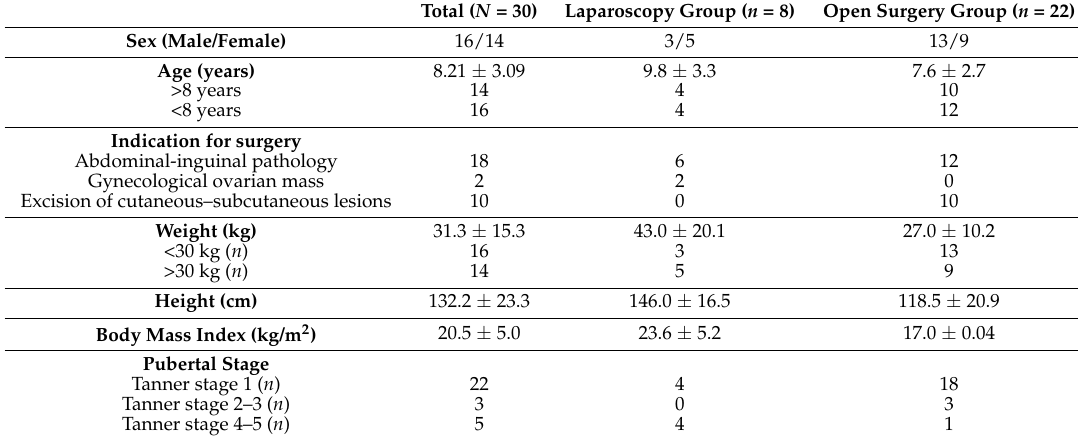
Table 1. Patients’ clinical data.